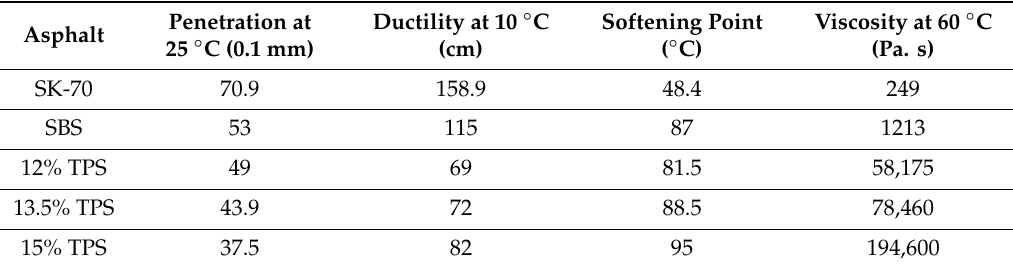
Table 2. The properties of different asphalts. SBS: Styrene-Butadiene-Styrene; TPS: Thermo Plastic Styrene.